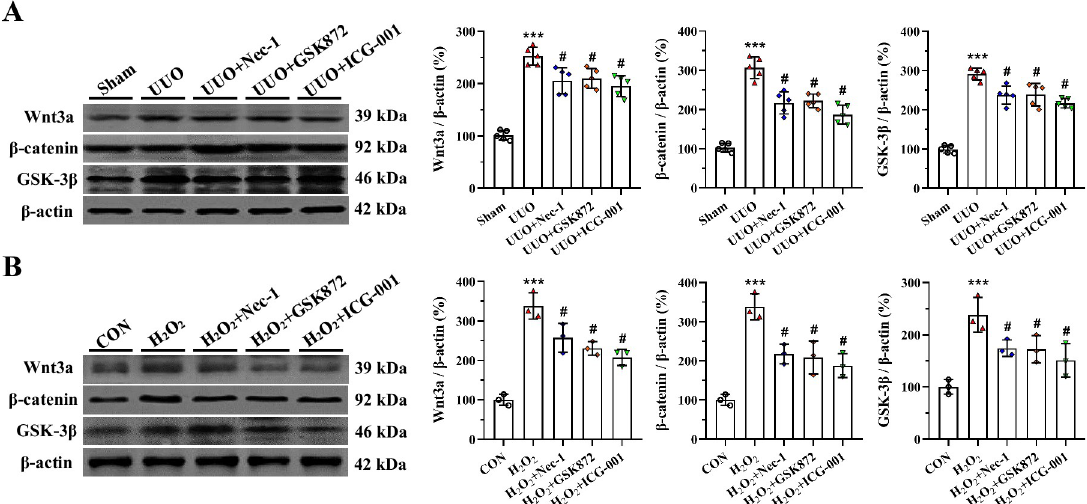
Fig 7. Representative photomicrographs of immunoblotting analysis of Wnt3 α / β -catenin/GSK-3 β signaling in vivo (A) and in vitro (B). ��� P < 0.01 vs. sham or control; # P < 0.05 vs. UUO or H 2 O 2 .